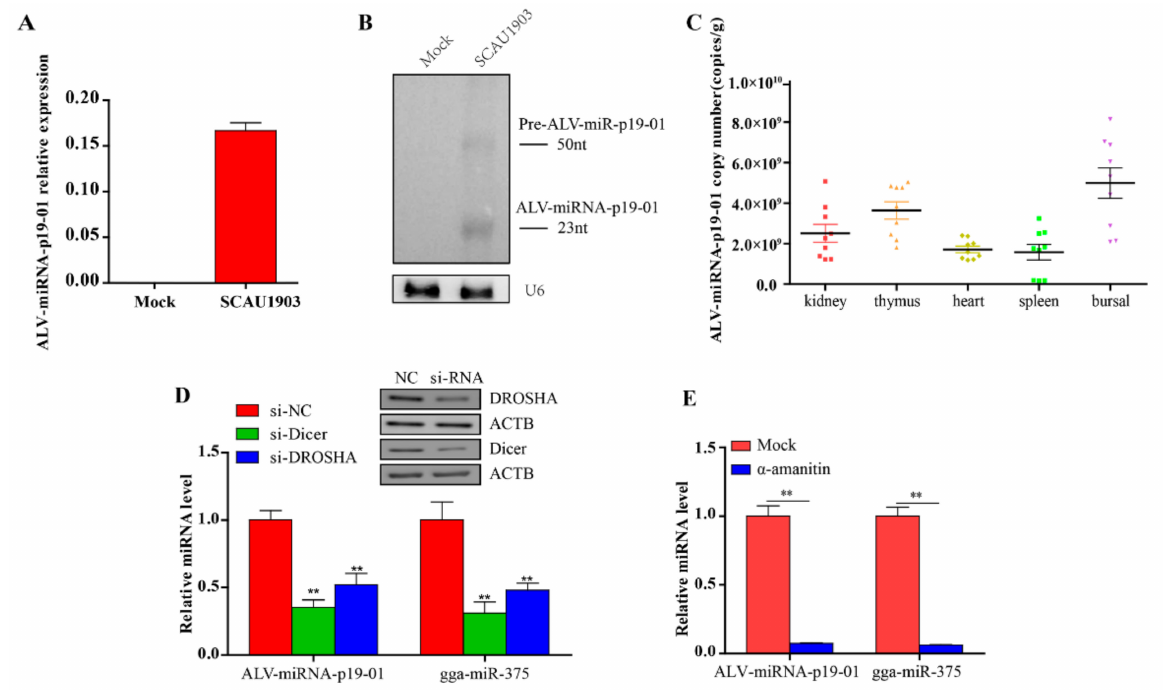
Figure 2. Experimental validation of ALV-miRNA-p19-01. ( A , B ) DF-1 cells were infected with ALV-J SCAU1903, normal cells as a negative control. ( A ) Mature ALV-miRNA-p19-01 were examined by stem-loop-RT-PCR in DF-1 cells. ( B ) ALV-miRNA-p19-01 was detected with Northern blotting. The probe was the biotin-conjugated antisense strand of ALV-miRNA-p19-01. Left: 30 µ g of small RNA from normal DF-1 cells; Right: 30 µ g of small RNA from DF-1 cells infected with ALV-J SCAU1903. U6 was used as a control. ( C ) The ALV-miRNA-p19-01 expression levels were measured by RT-PCR in different tissues of ALV-J-positive chickens. ( D ) Dicer and Drosha were suppressed with siRNAs in DF-1 cells, and ALV-miRNA-p19-01 expression was detected by RT-PCR. NC, normal control. ( E ) DF-1 cells were infected with ALV-J SCAU1903 and then treated with α -amanitin. ALV-miRNA-p19-01 expression was detected by RT-PCR. Statistically significant values are indicated by ** p <